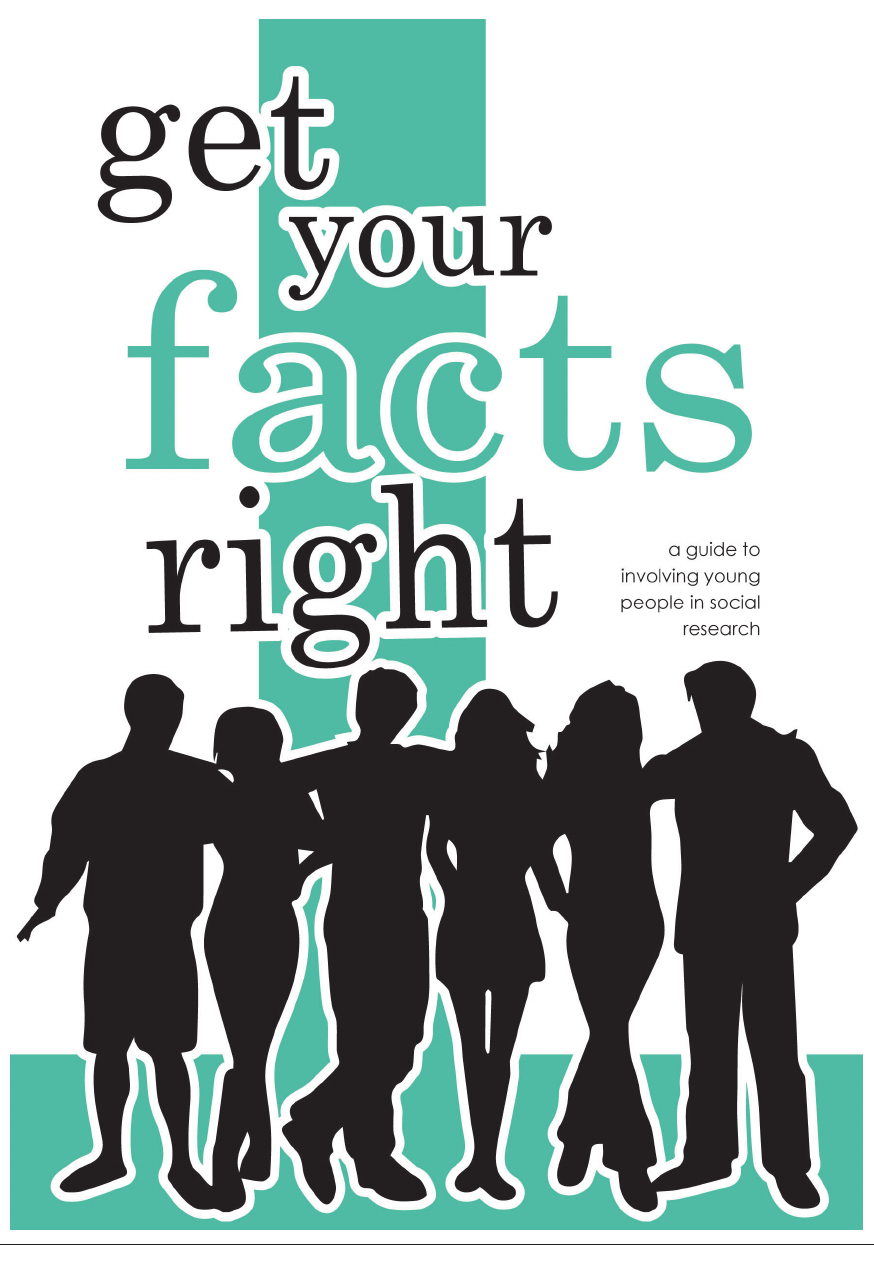
Figure 1: Get Your Facts Right , a youth-centred research